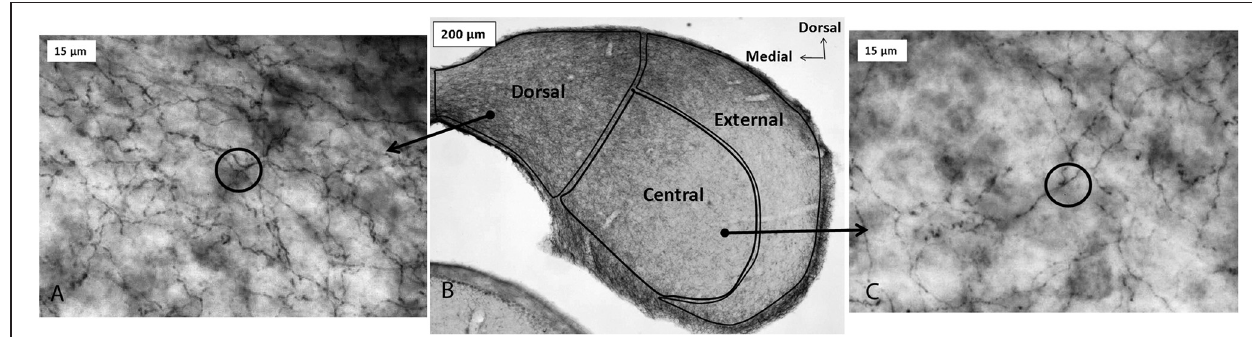
immunostainedfibersinthedorsalcortexandcentralIC,respectively.Circlesin panels (A) and (C) depictsoftwareprobesusedtoestimatefiberdensity. AllpanelswerereprintedwithpermissionfromElsevier;additionalinformationon